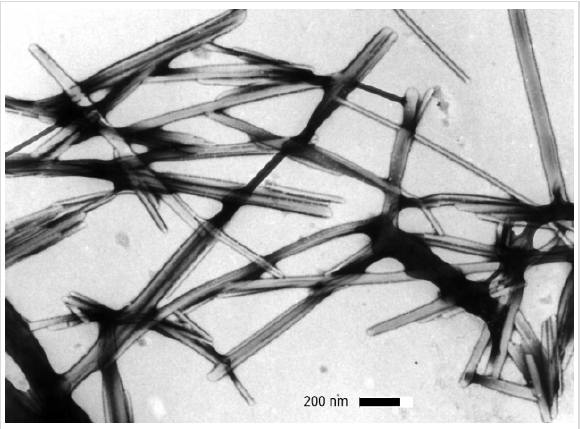
Figure 2: TEM images (PWK staining) of: ( S , S ) -1a H 2 O/DMSO gel.